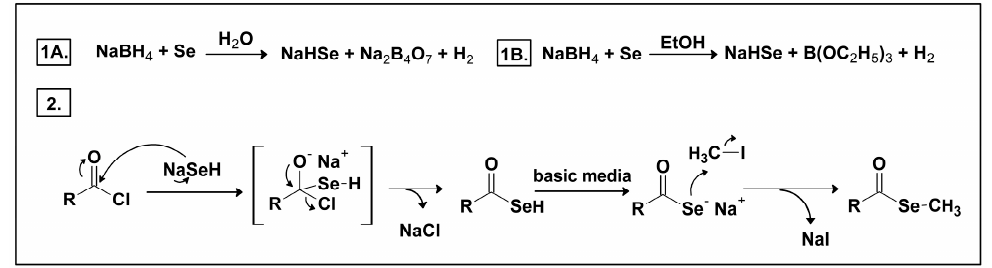
Scheme 1. Synthesis of the methylselenoesters. Synthetic procedure and proposed reaction mechanism for the formation of the